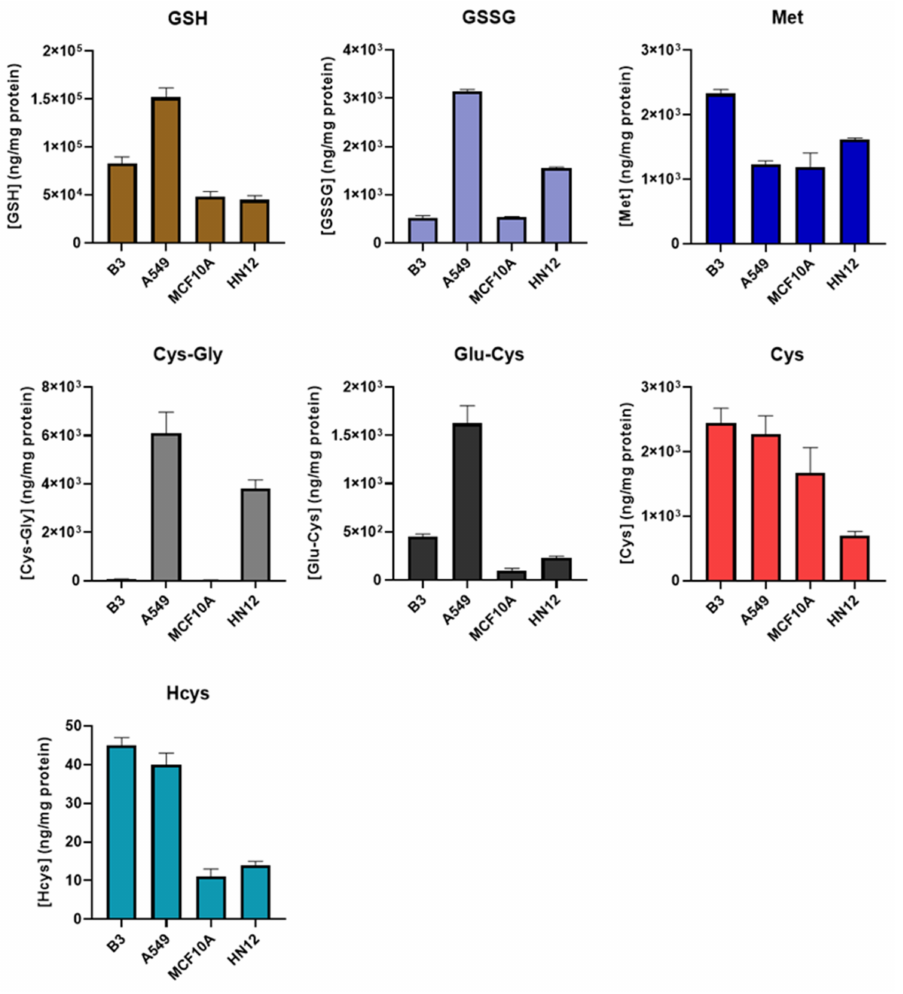
Figure 3. Comparison of thiol profile in different cells. B3, human lens epithelial cells, n = 6; A549, human lung carcinoma cells, n = 6; MCF10A, human breast epithelial cells, n = 3; HN12, human head and neck squamous cell carcinoma line, n = 3. Values are reported as mean ±